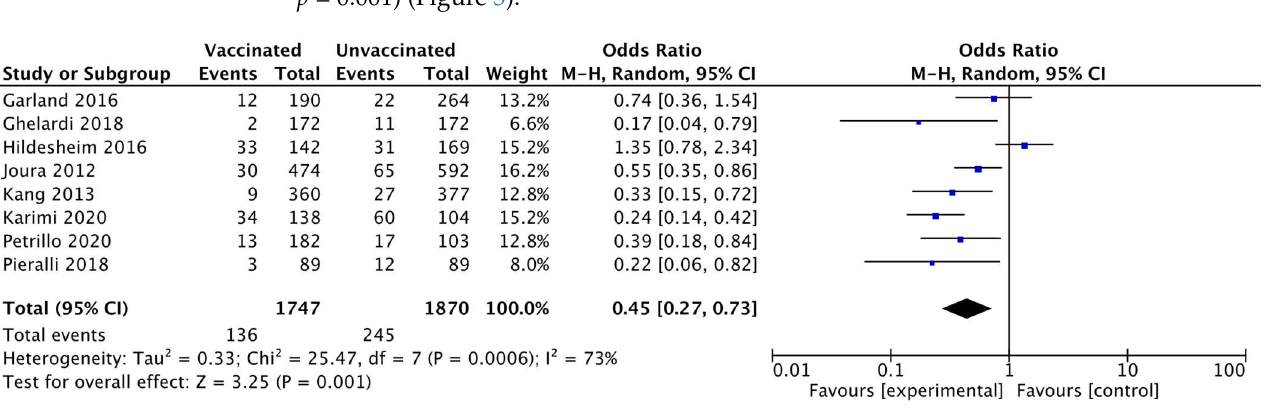
Figure 5. Forest plot of comparison: CIN 1+ recurrence.